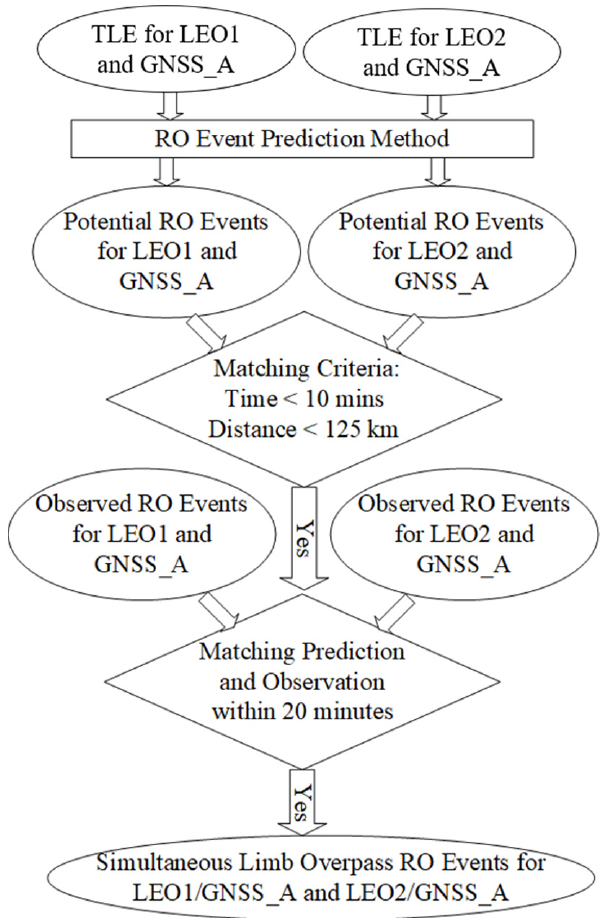
Figure 7. Procedures to obtain the simultaneous limb overpass RO events from two receivers on different LEOs with the same GNSS satellite.